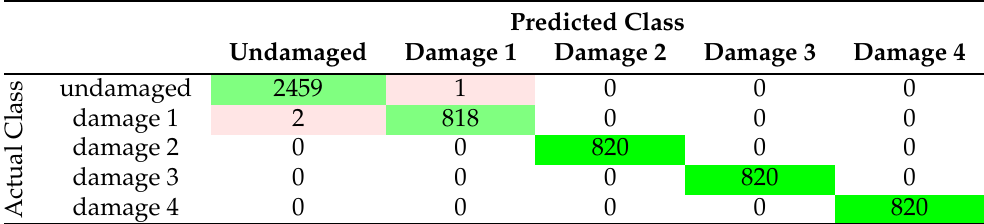
Table 10. Total added confusion matrix for d = 21. Correct decisions are placed in cells with green background while wrong decisions are placed in cells with red